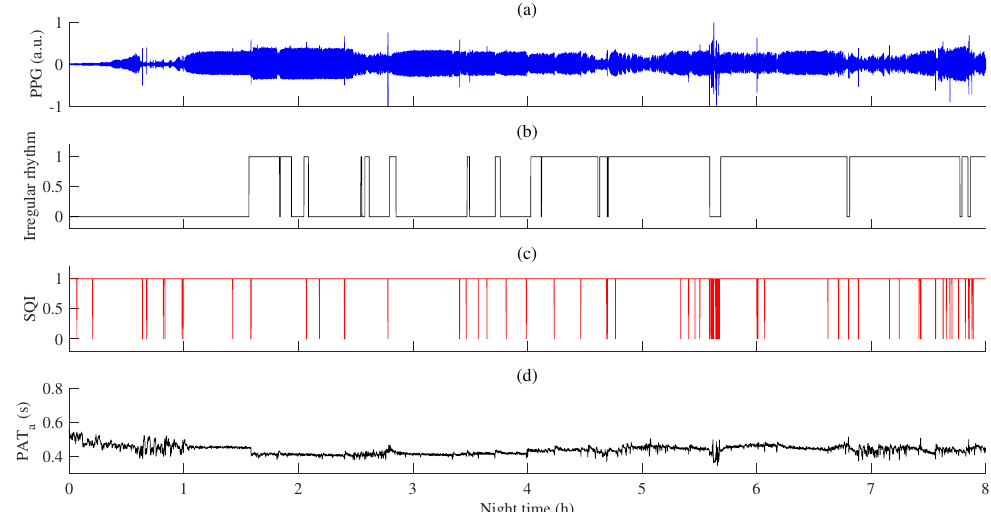
Figure 9. An example of PAT variations during regular and irregular rhythms: ( a ) PPG signal; ( b ) detected episodes of irregular rhythm (1—irregular rhythm, 0—regular rhythm); ( c ) PPG signal quality estimated by the ECG-guided algorithm, SQI (SQI = 1—high-quality, SQI = 0—low-quality); ( d ) PAT after post-processing, PAT a